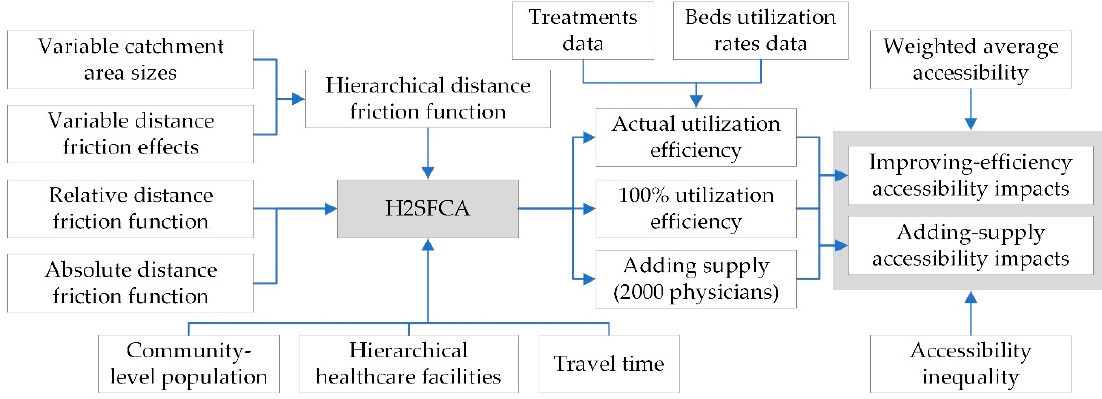
Figure 2. The framework of this study.